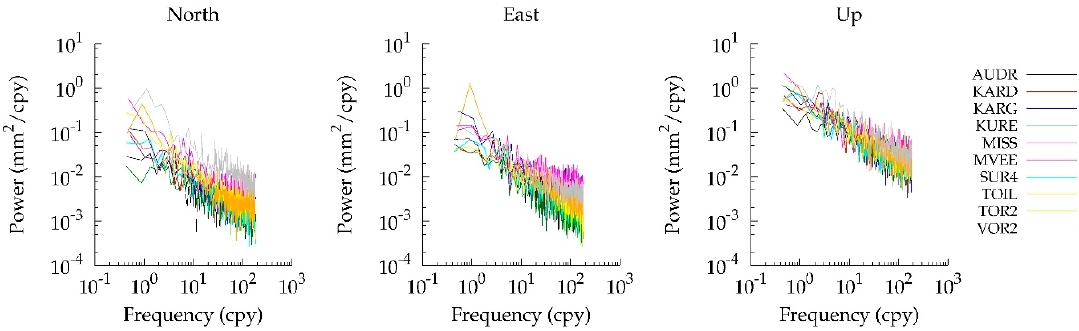
Figure 4. Power spectral densities of the BERN time-series residuals based on the solution BERN_2.